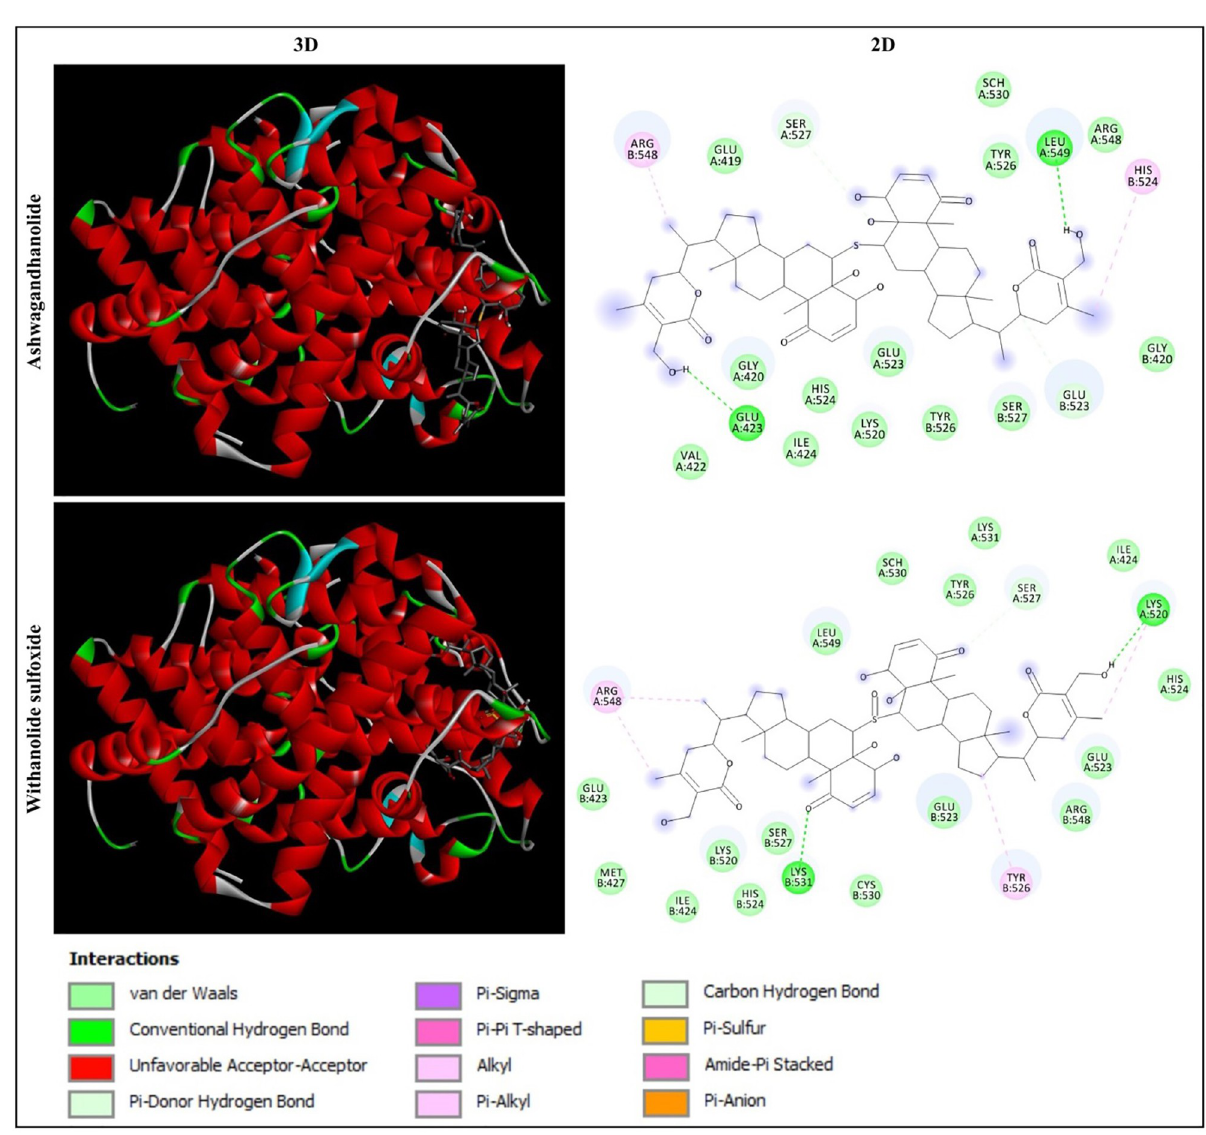
Fig 4. Interaction of ER α (PDB: 6CBZ) with Ashwagandhanolide and Withanolide sulfoxide. Three-dimensional (3D) illustration shows the interaction of ligands with ER α structure and two-dimensional (2D) diagram displays the interactions of the ligand with the specific amino acid residues in the active site of the